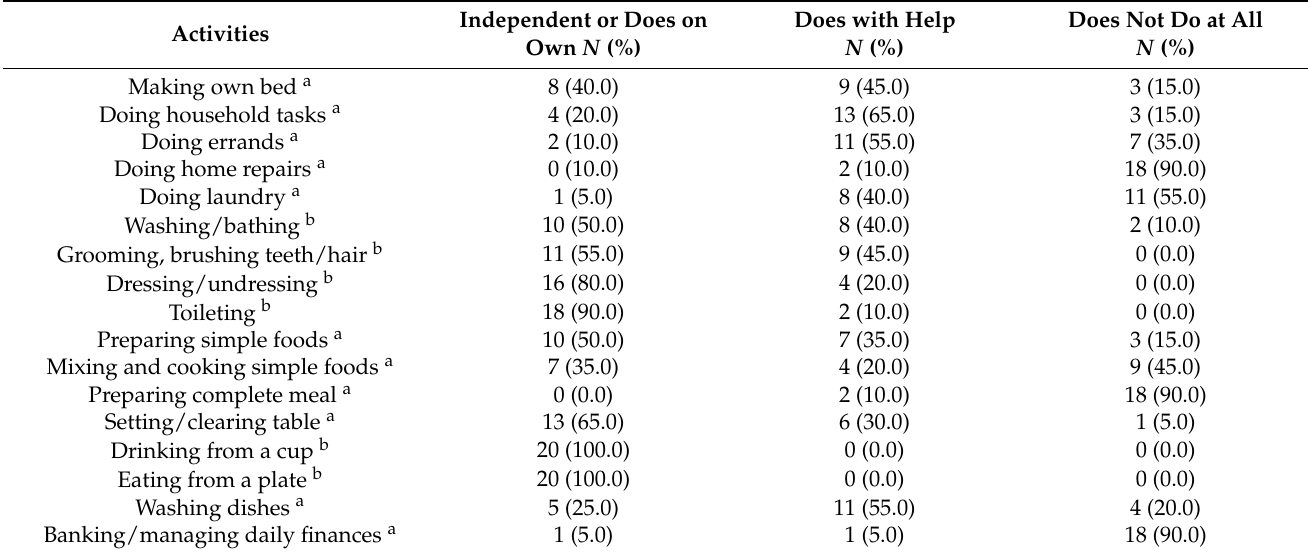
Table 2. Performance of basic (ADL) and instrumental activities of daily living